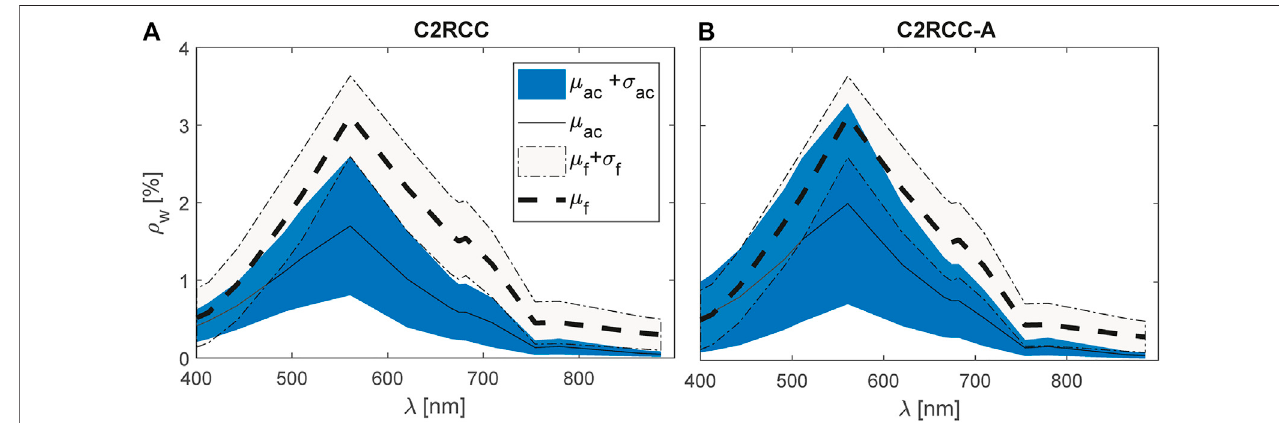
FIGURE 3 | Summary of the results from applying atmospheric correction to S3-OLCI using (A) C2RCC and (B) C2RCC-A. Solid lines depict average values, whereas shaded areas represent the variability as standard deviation. The subscripts, ac , f refer to atmosphere correction and fi eld spectra, respectively.